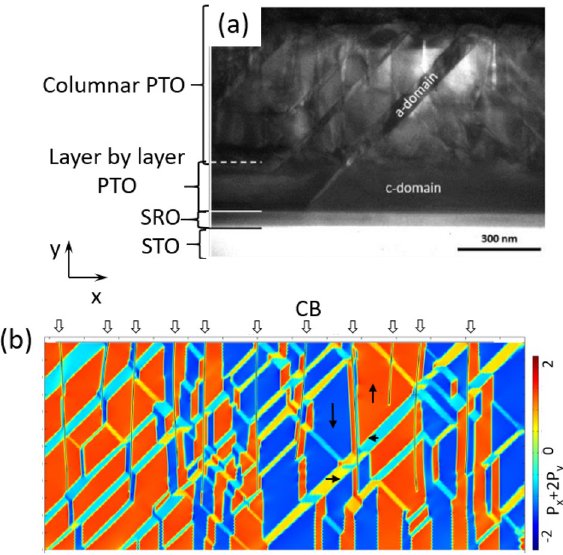
Figure 1. Domains in the columnar thin film. ( a ) Low-magnification cross-sectional transmission electron microscopy image in [110] direction. ( b ) Phase field simulation (c-domains are blue and red, a-domains are yellow and